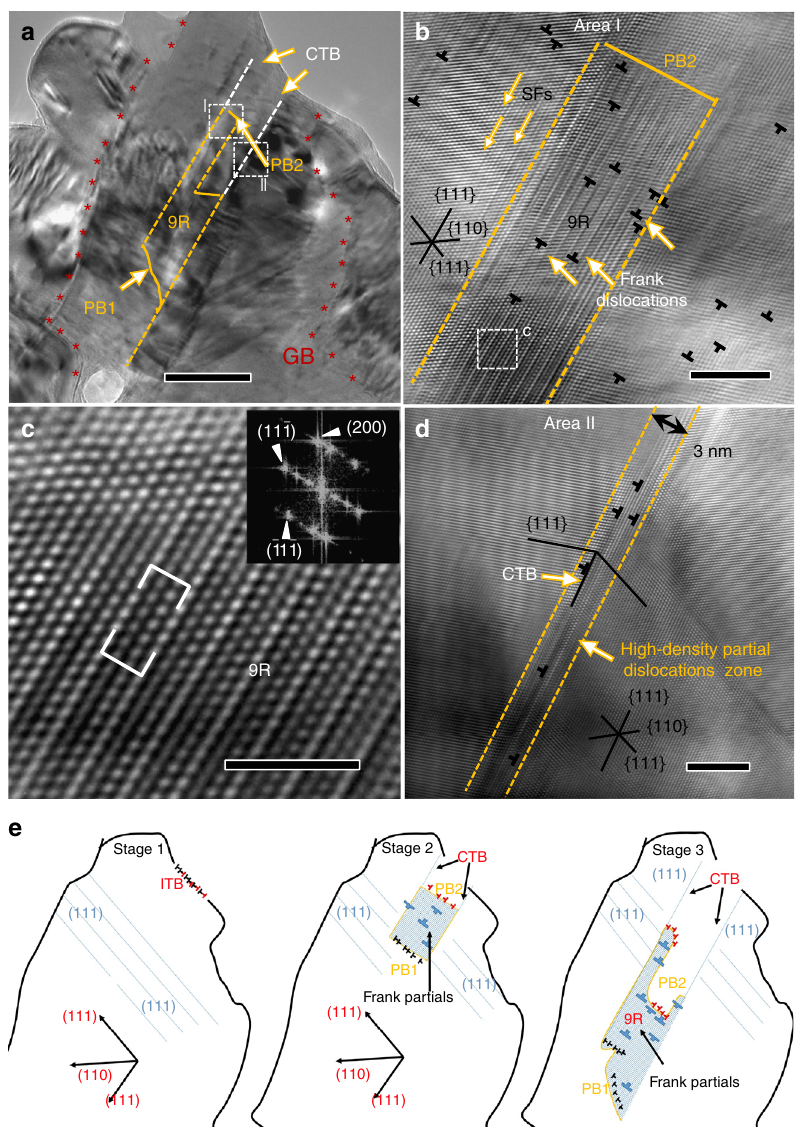
Fig. 3 Projectile impact induced 9R phase in UFG Al fi lms. a Overview of the microstructures of UFG Al adjacent to the edge of the perforated hole. CTBs bounding a giant 9R phase are identi fi ed. The phase boundaries (PB1 and PB2) separating the 9R phase from the matrix are also labeled. Two white boxes outline the defects shown at higher magni fi cation in c , d . Red asterisks outline a grain boundary (GB). Scale bar, 50 nm. b The HRTEM micrograph reveals the formation of the giant 9R phase in UFG Al after impact. Numerous Frank partials are also observed in the 9R phase. Scale bar, 5 nm. c The HRTEM micrograph of the CTB from area 2. High-density Shockley partials are identi fi ed along the CTB. Scale bar, 2 nm. d HRTEM micrograph of the white box in b showing the 9R phase. Scale bar, 5 nm. e A schematic shows the deformation-induced 9R phase and the TBs. A section of the GB has the nature of an ITB with one Shockley partial on each adjacent {111} plane. High-strain-rate impact triggers the migration of partials along the ITB. The giant 9R region is over 100 nm long and is bounded between PB1 and PB2. Sessile Frank partials also form within the 9R phase and pin the trailing partials, stabilizing the 9R phase after the high-strain-rate